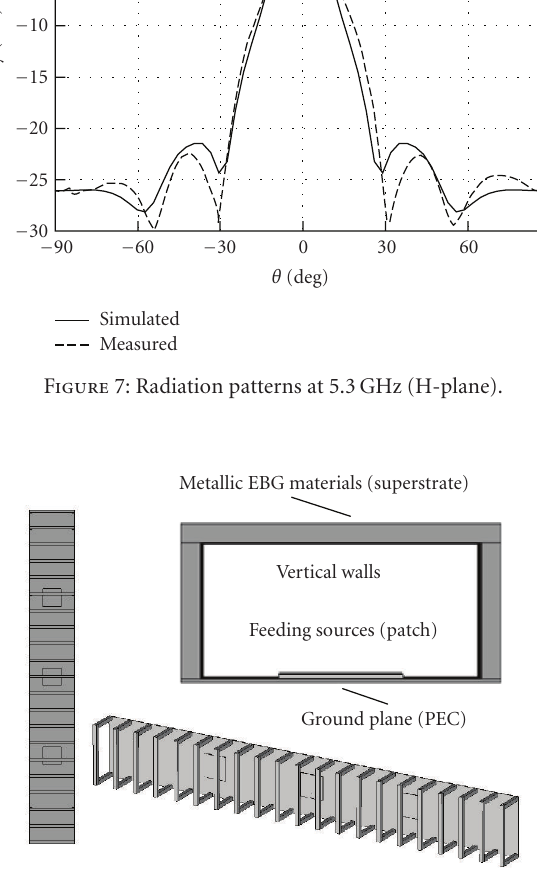
Figure 6: Radiation patterns at 5.3 GHz (E-plane).